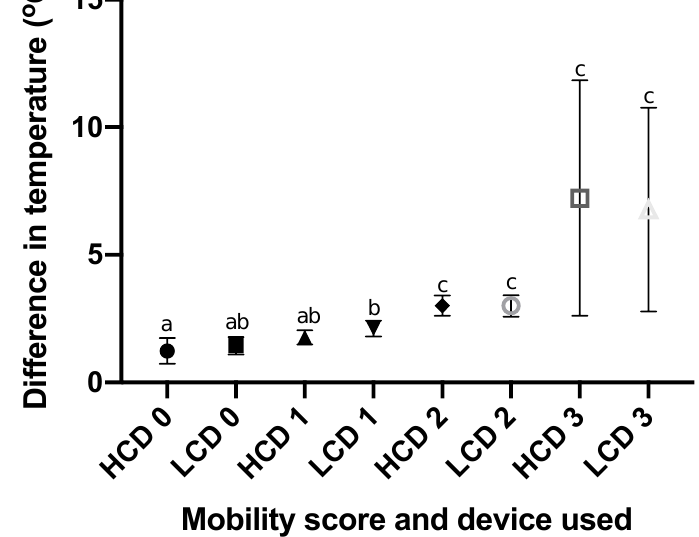
Figure 8. A graph showing the mean and 95% confidence interval of temperature difference between the hind feet of each individual cow, for each AHDB mobility score 0, 1, 2, and 3 (n = 43, 160, 110, and 8, respectively; both devices had an equivalent n in corresponding groups). This graph shows both the data set obtained from the CAT S62-Pro Smartphone (LCD) and that from the FLIR T620bx (HCD). abc different superscripts indicate significant differences between means at p < 0.05.